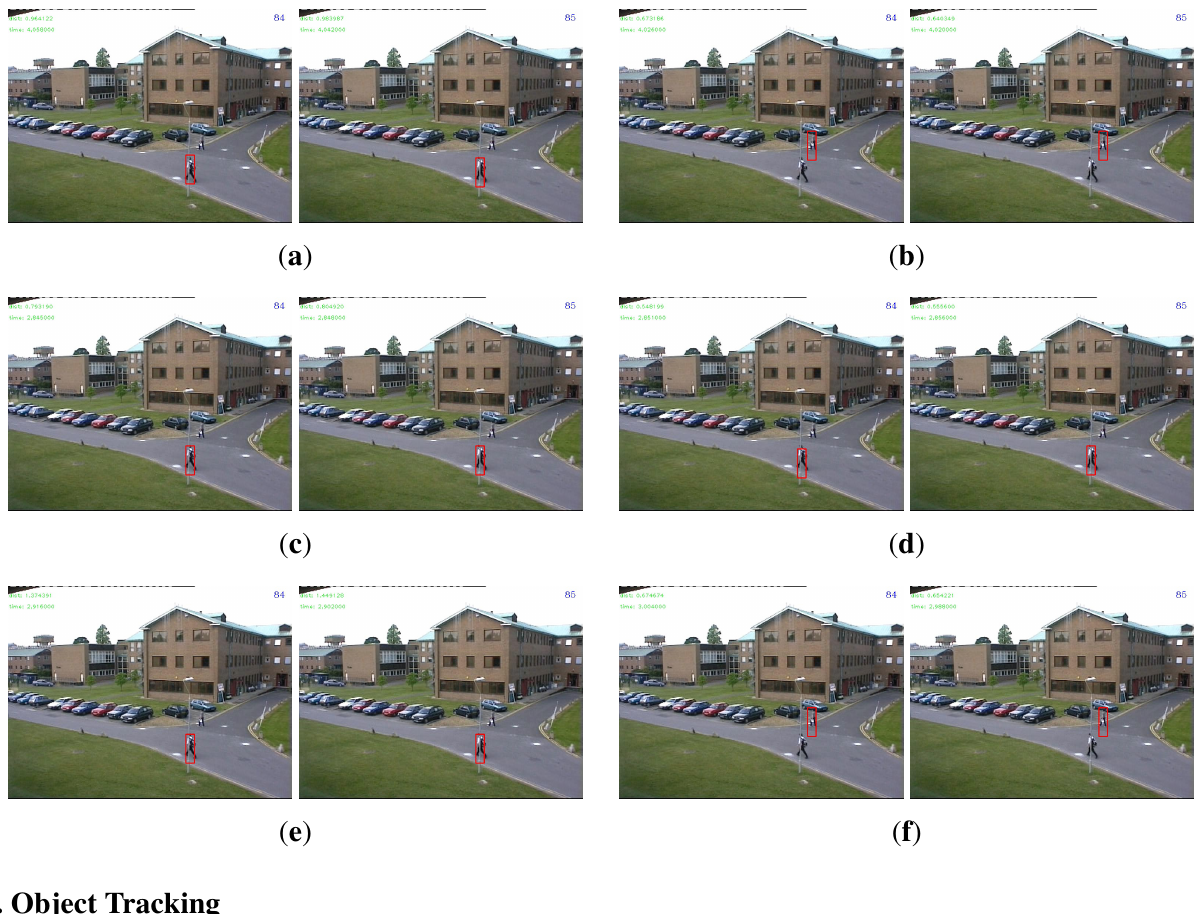
Figure 4. Detection results in the 84th and the 85th frames of the “PETS” sequence. See text for details. The initial frame with the target marked in rectangle is shown in Figure